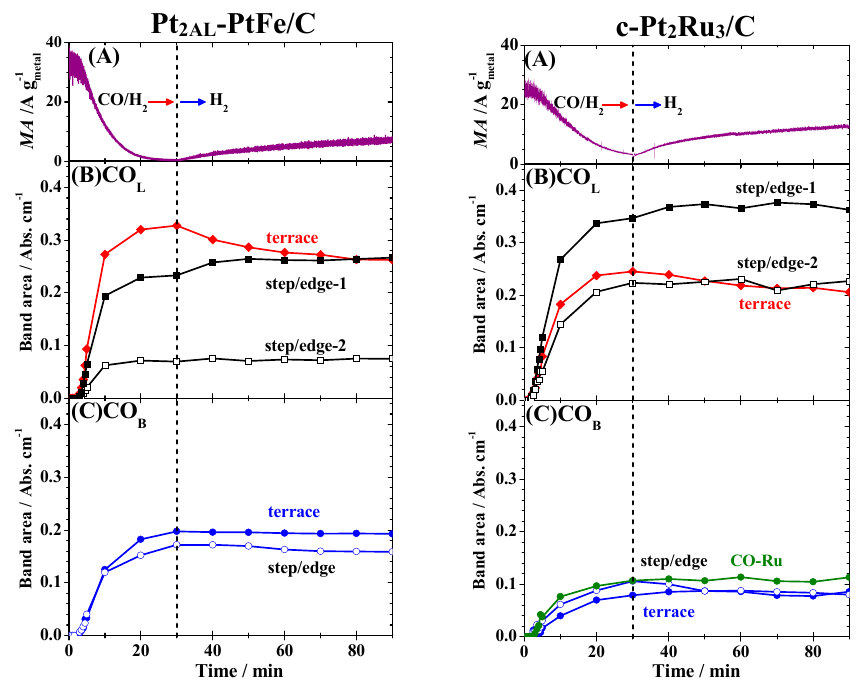
Figure 7. Time courses of the mass activity ( MA ) for the HOR ( A ) and integrated intensities of I [CO L ] ( B ), and I [CO B ] (C) observed at 0.02 V and 60 °C in 0.1 M HClO 4 . First, CO was adsorbed on the working electrode at 0.02 V by bubbling 1% CO (H 2 ‐ balance) at a flow rate of 10 mL ∙ min − 1 for 30 min, and CO ‐ free pure H 2 gas was then bubbled in the solution at a flow rate 10 mL ∙ min − 1 for an additional 60 min.